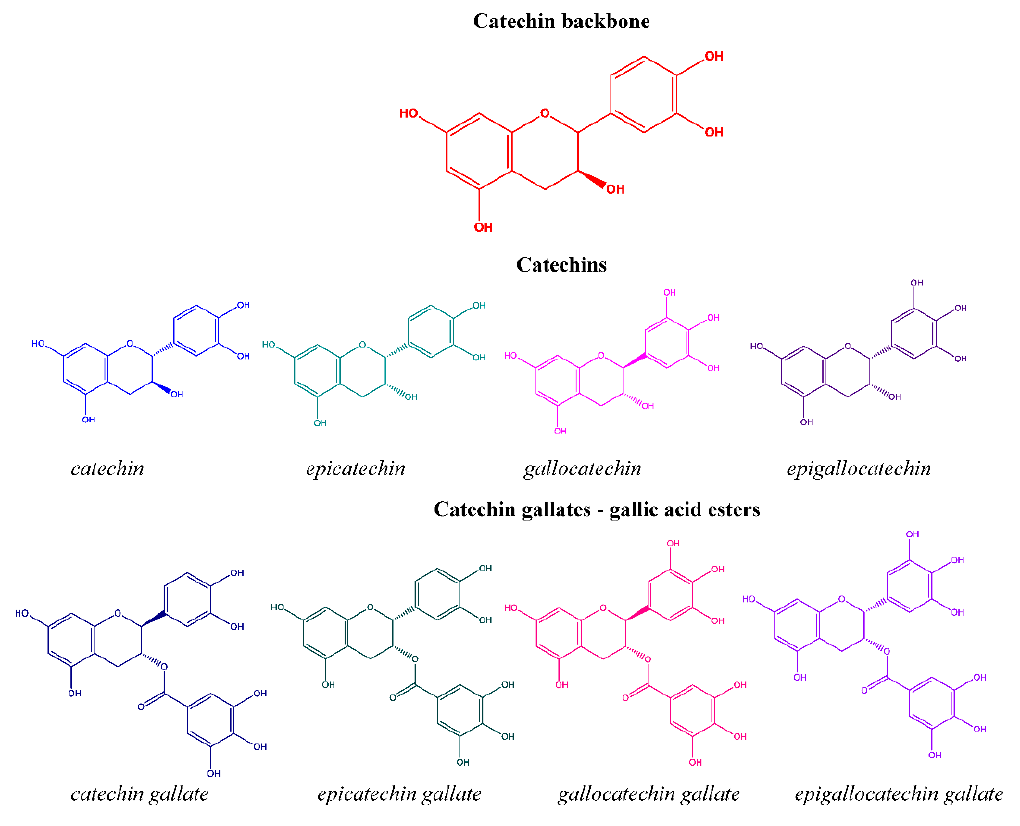
Figure 1. Structural formulas of the catechin family.